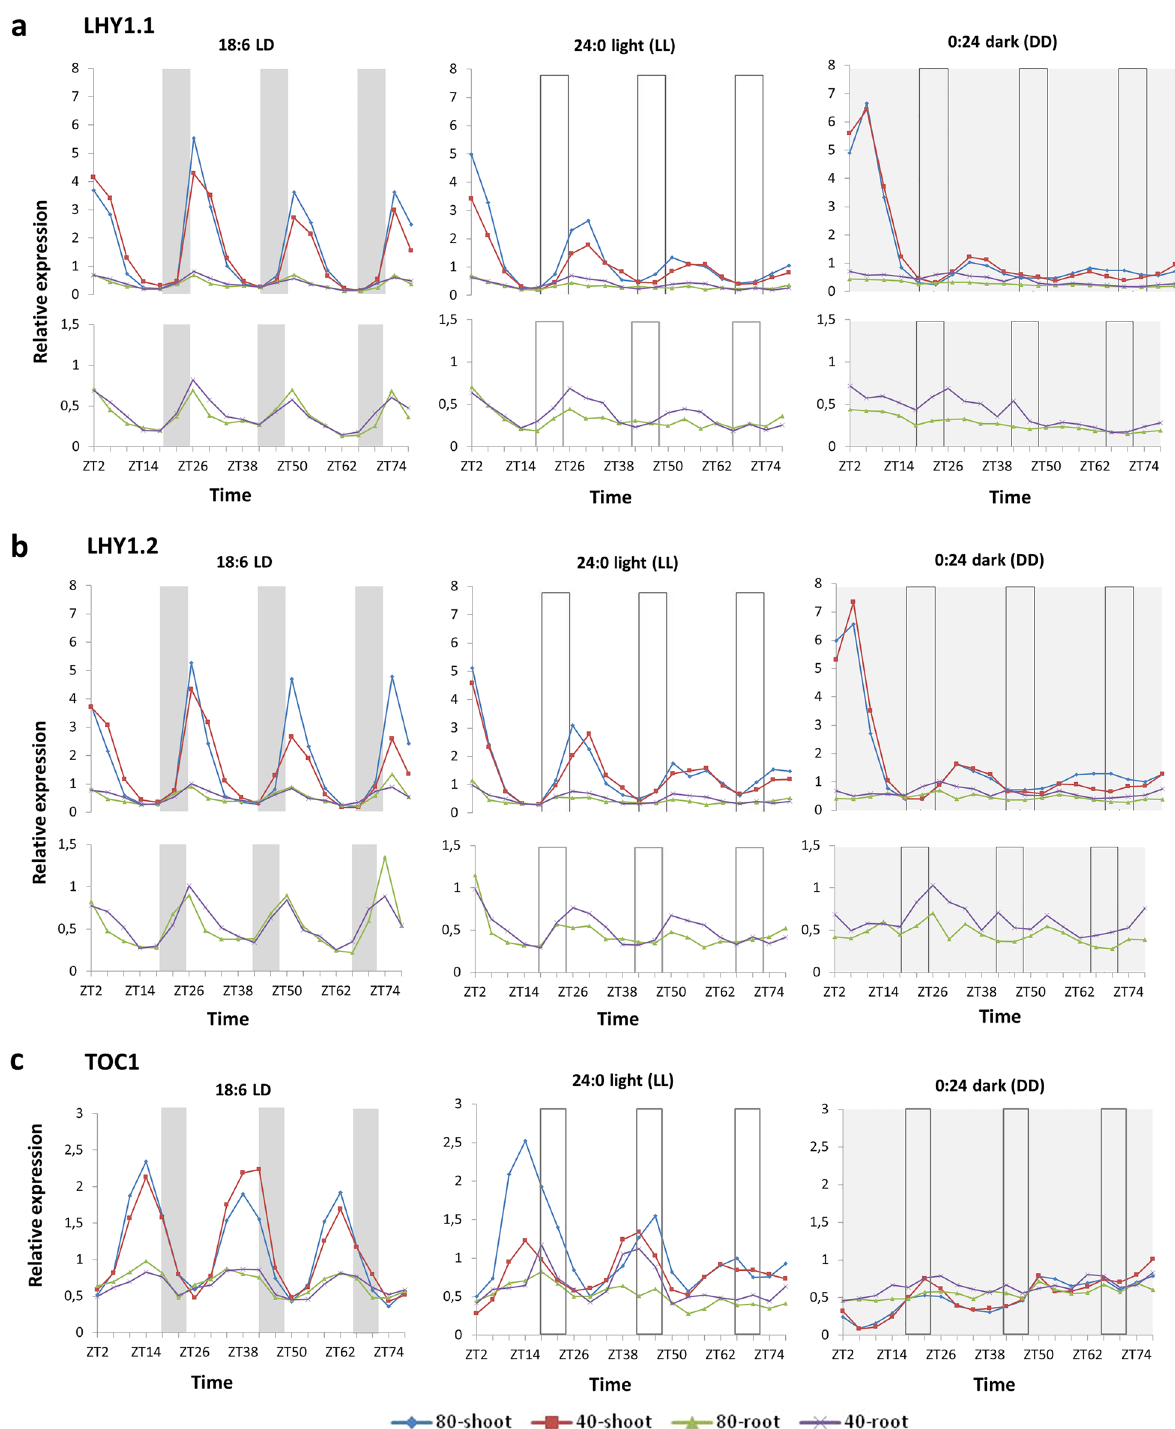
Figure 1. Time scale expression of Brachypodium distachyon central loop genes. Gene expression of two transcript variants of BdLHY [ BdLHY1.1 ( a ) and BdLHY1.2 ( b )] and BdTOC1 ( c ) was monitored by qRT-PCR over 76 h in total aerial parts (shoot) and total roots (root) of Brachypodium distachyon under two watering conditions [80% soil water content (80) and 40% soil water content (40)] and three lighting regimes (18:6 light:dark, 24:0 light and 0:24 dark). Plants were entrained for 4 weeks in 18:6 light: dark cycles (light period: 6:00 to 24:00; dark period: 24:00 to 6:00) before being exposed to the three different lighting regimes. As regards water status, plants were grown with 80% soil water content for 2 weeks before being subjected to modest water deprivation (40% soil water content) for 2 weeks before sampling. Bars represent the periods of night (grey bars) and subjective night (empty bars). Expression levels shown are relative to average expression of two reference genes ( BdUBC18 and BdElFα ) and relative to the mean expression level of the target gene over 76 h in shoots grown under 18:6 light:dark cycles and 80% soil water content. Data shown are from two representative experiments. The related period, phase, amplitude and relative amplitude error dataset can be found in Table 1. The standard deviation and related expression dataset from the two experiments are shown in Supplementary File